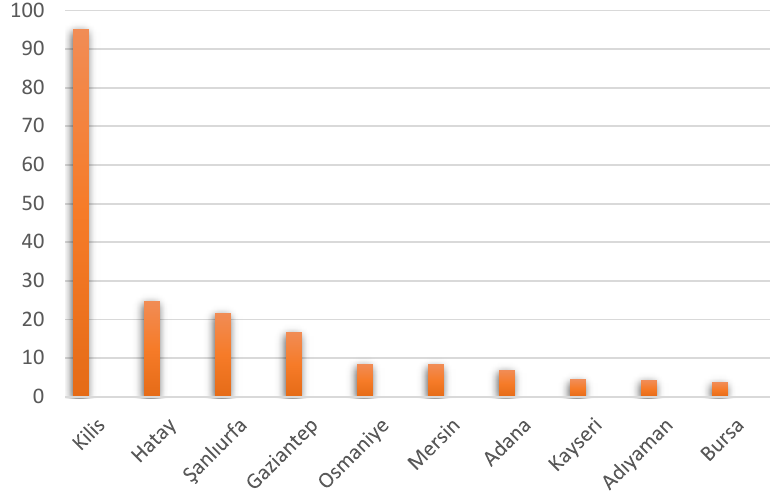
Figure 2. Top ten provinces in terms of the share of Syrians in population. Source: Directorate General of Migration Management.